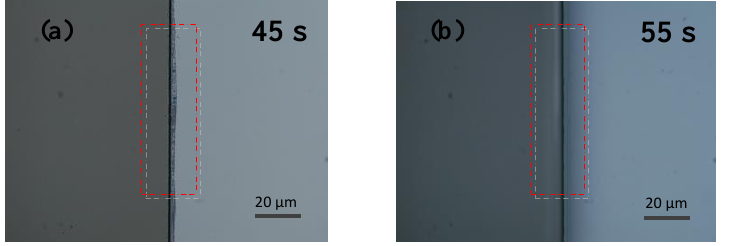
Figure 9. The microscope photos of the two samples with different develop times: ( a ) 45s, undevel- oped, residual photoresist in the marginal area; ( b ) 55s, develop, no residual photoresist.